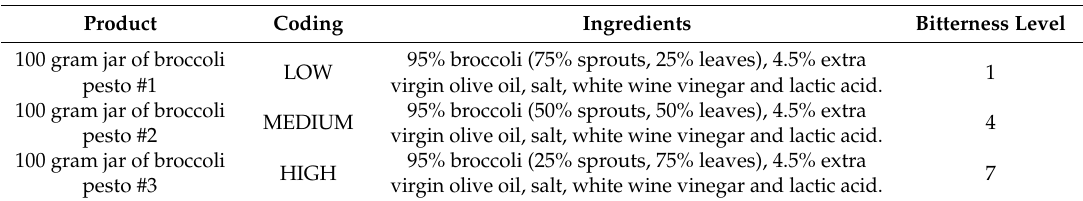
Table 1. Experimental products’